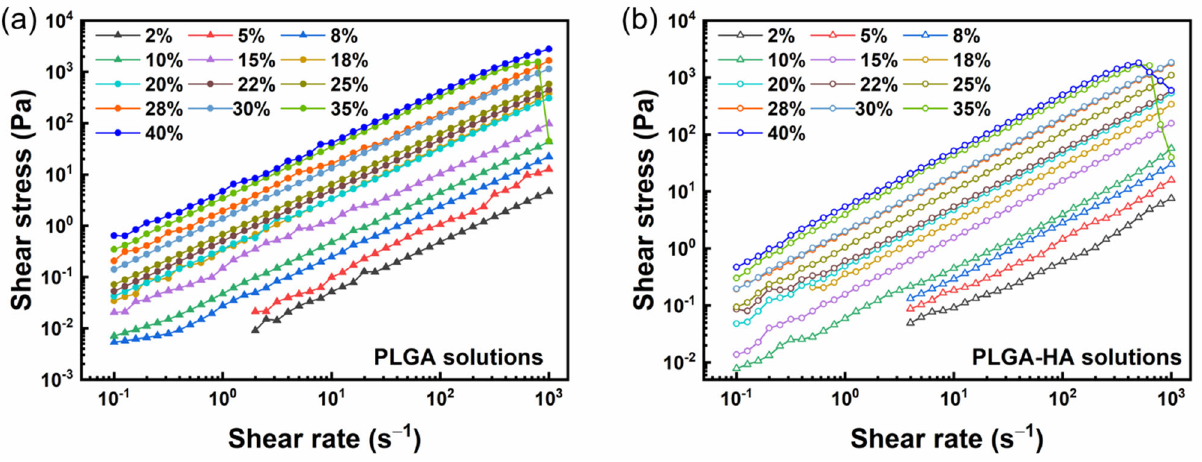
Figure 2. Dependence of shear stress on shear rate for ( a ) PLGA in DMSO solutions and ( b ) PLGA ‐ 1.5% HA in DMSO solutions.